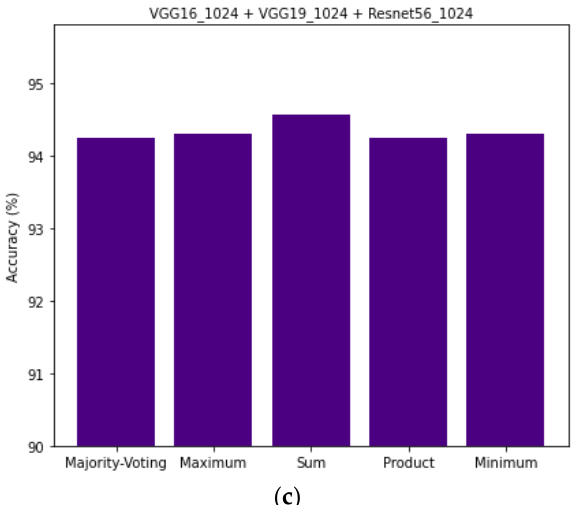
Figure 8. ( a – c ): Accuracy using different fusion strategies in case of fusion of different models with same batch sizes.